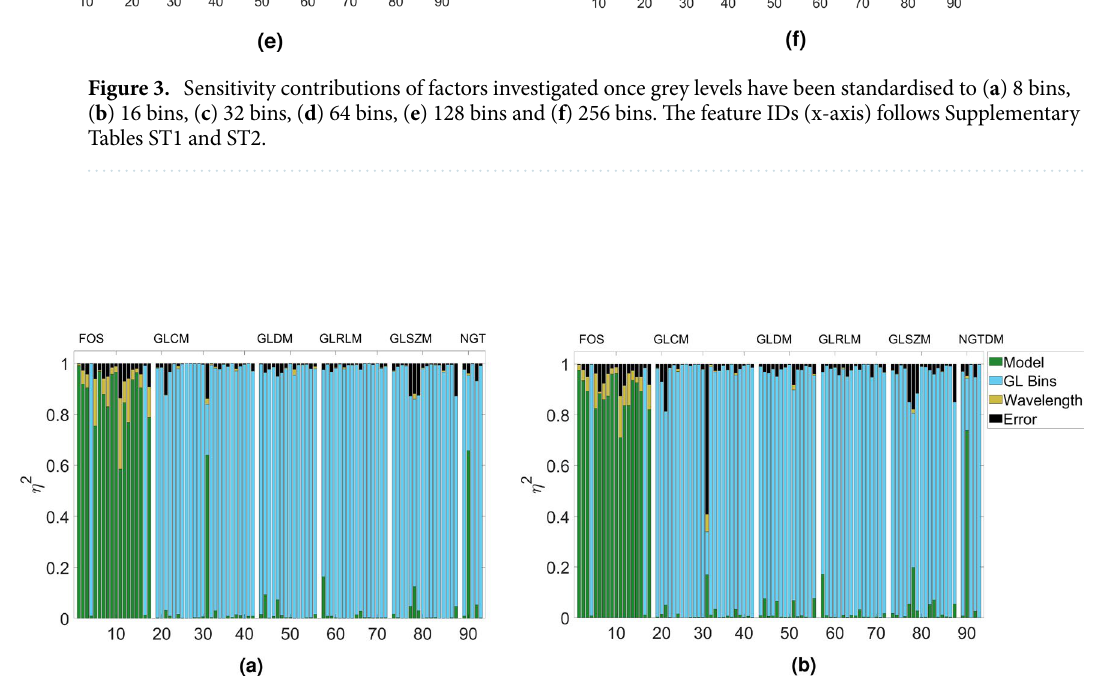
Figure 4. Sensitivity contribution of factors investigated once grey levels have been standardised for reconstruction type where ( a ) is Backprojection and ( b ) is Model linear